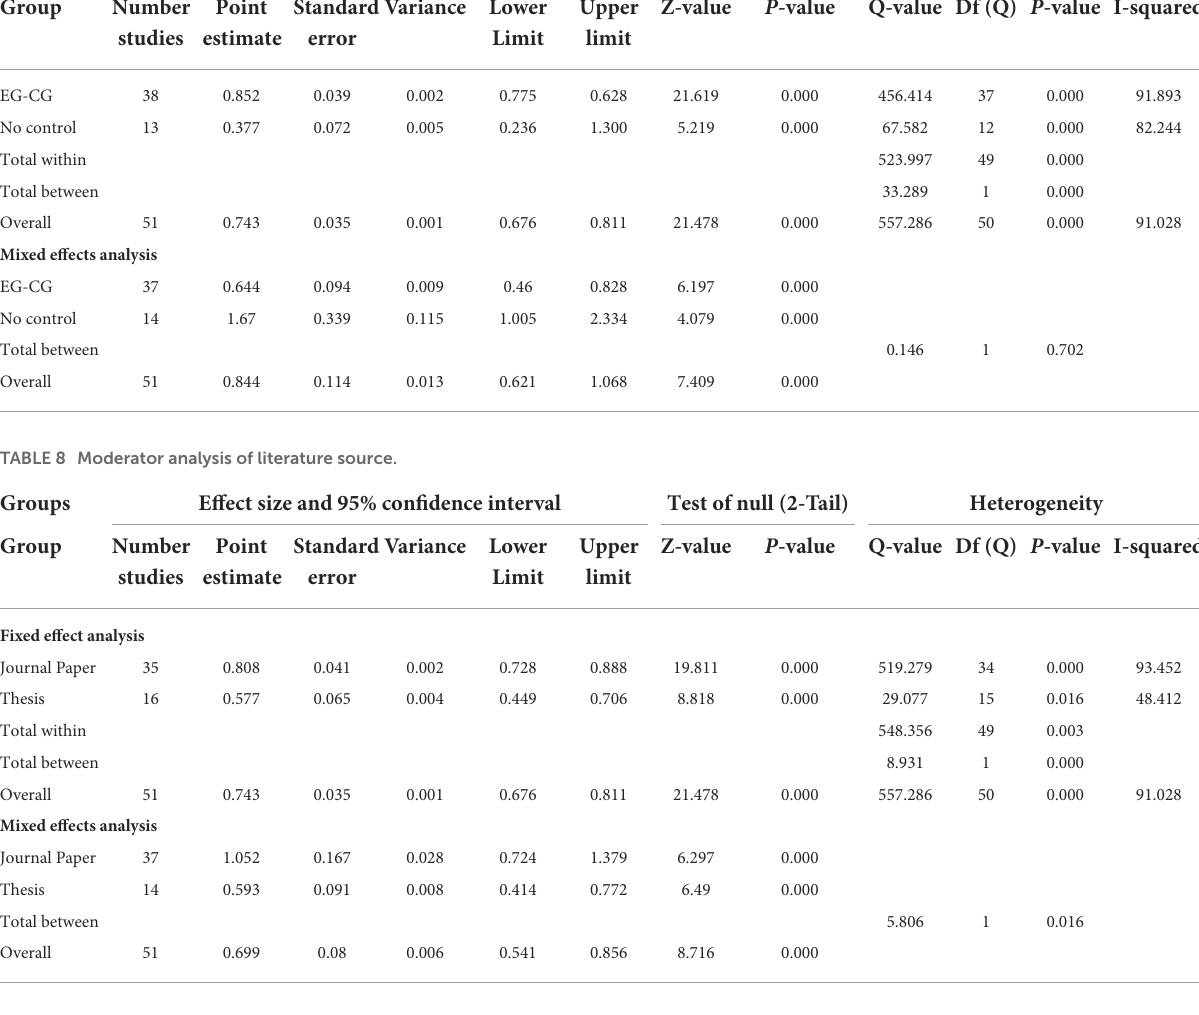
TABLE 9 Regression results of intervention length and intervention effect. Main results for model 1, random effect (ML), Z-distribution, Std diff in mean